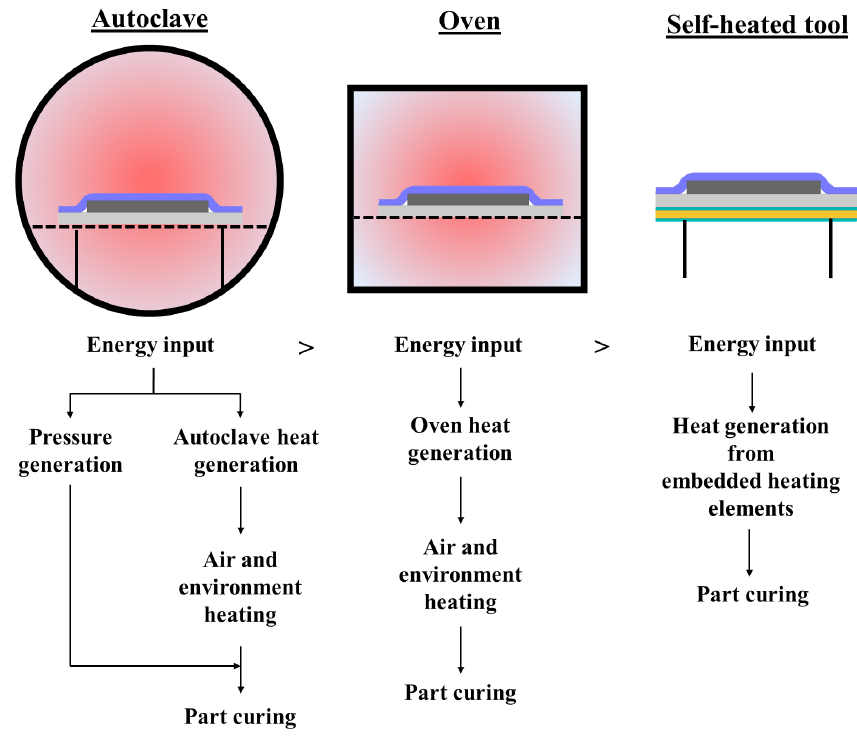
Figure 1: An illustration of the energy required to cure composite parts using various manufacturing techniques.